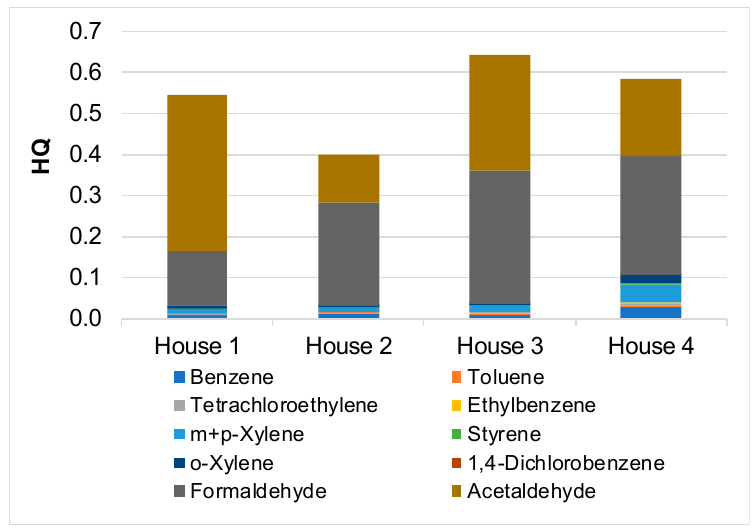
Figure 6. Hazard quotients (HQ) for individual VOCs for the four dwellings.